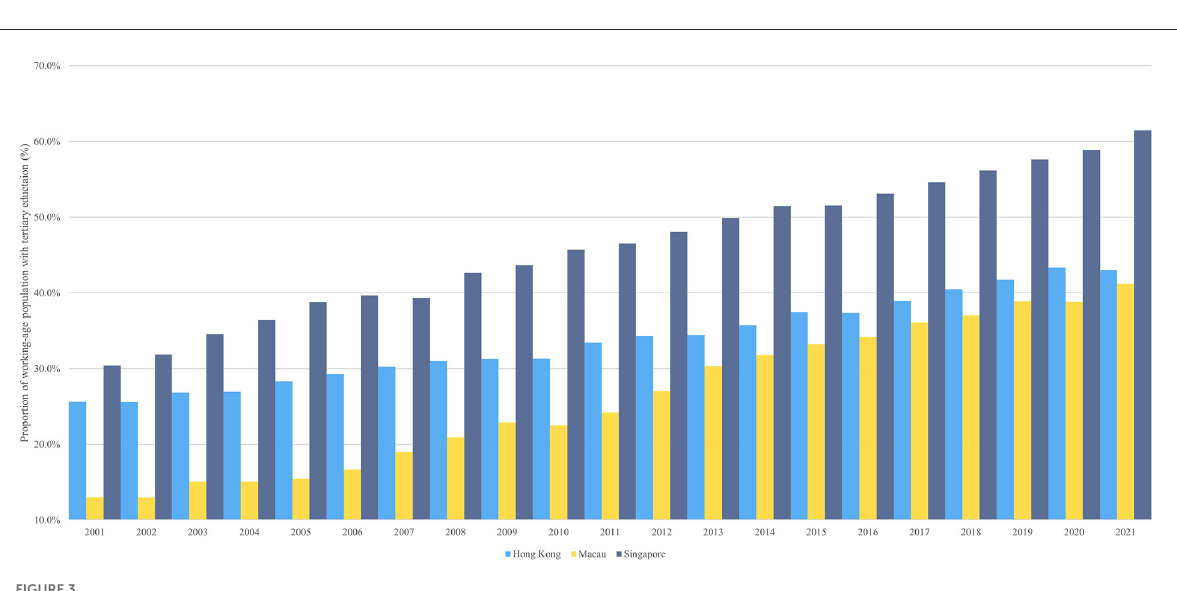
FIGURE2 OADR and its annual increasing rate since entering an aging society.